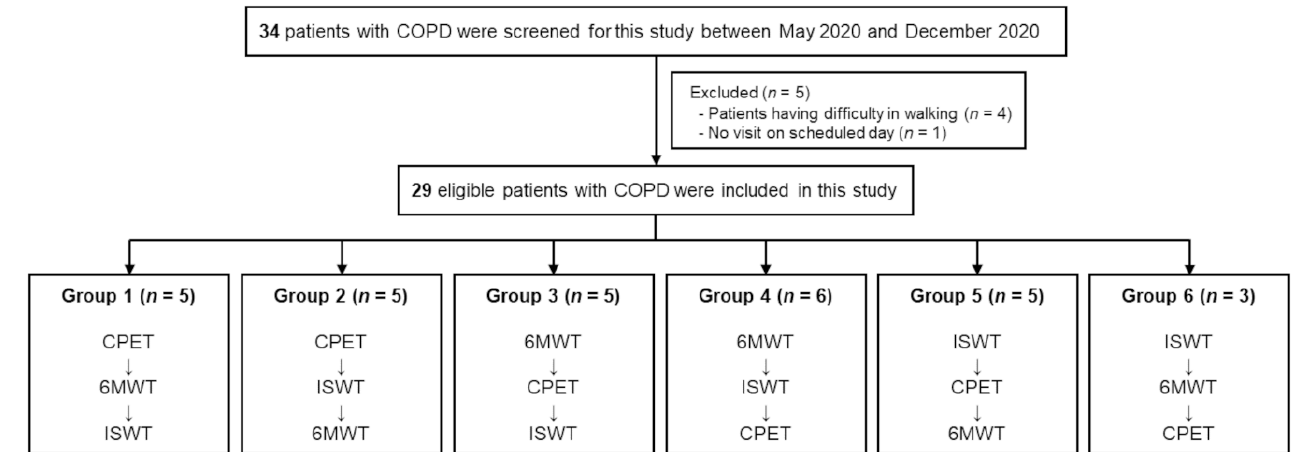
Figure 1. Study flowchart. Three assessments (CPET, 6MWT, and ISWT) were performed in 2-day intervals on all patients, according to the group the patients were assigned. Patients were randomly assigned to the six test order groups using randomly generated treatment allocations with sealed opaque envelopes created by an impartial researcher. Abbreviations: 6MWT, 6 min walking test; CPET, cardiopulmonary exercise test; ISWT, incremental shuttle walking